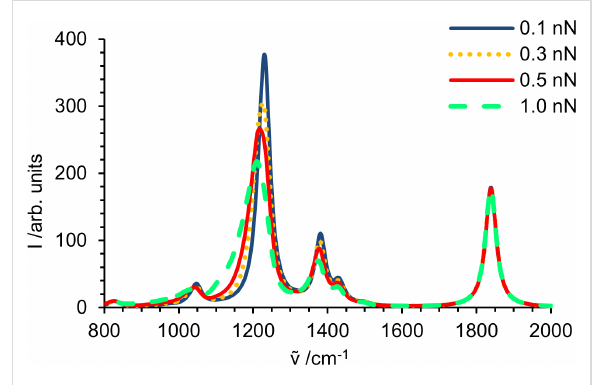
Figure 6: Fingerprint region of a simulated spectrum of a propyl propanoate solid sample at 0.1, 0.3, 0.5 and 1.0 nN mean force per polymer